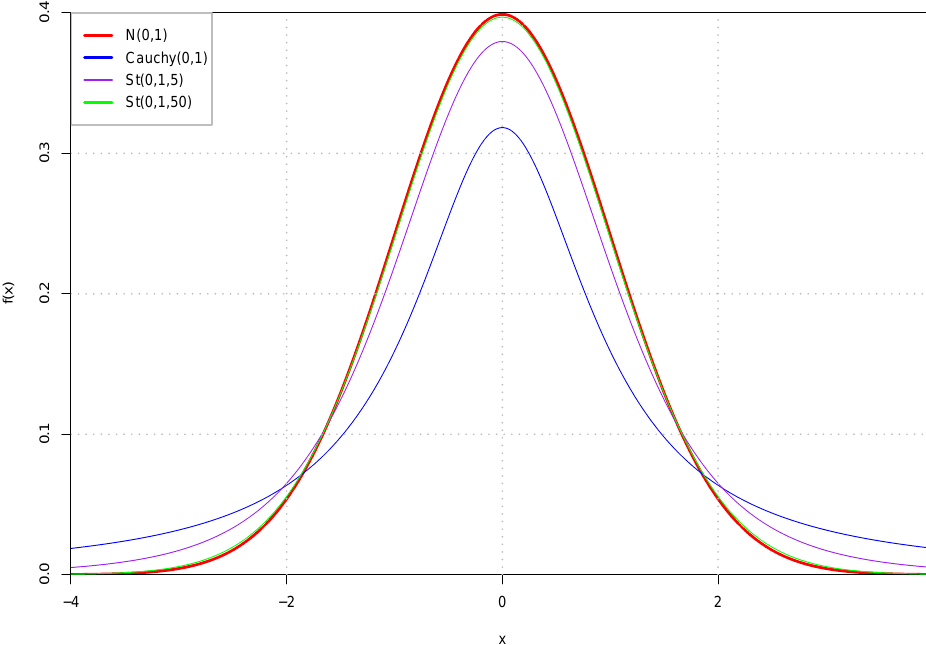
Figure 1. Several probability distribution function curves of common probability distribution. They share the same mean and scale parameters, and there are two St distribution with dof parameter 5 and 50 respectively.